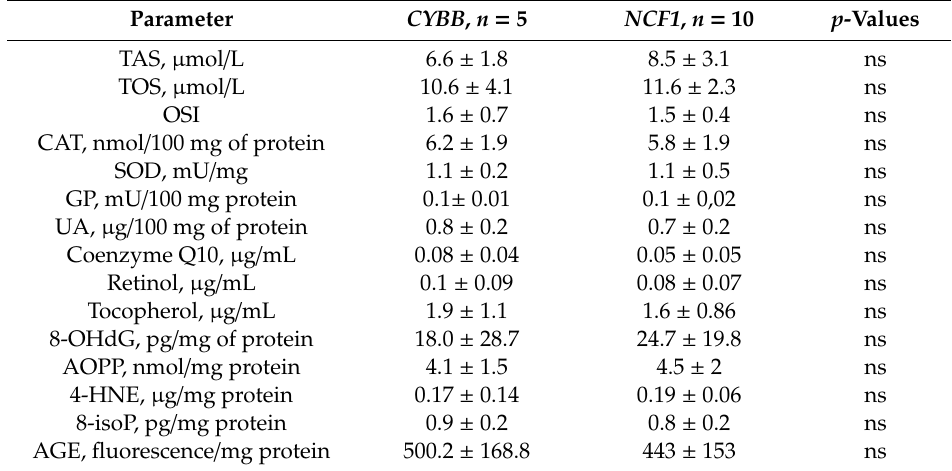
Table 3. Comparison of examined redox parameters in chronic granulomatous disease (CGD) patients with CYBB and NCF1 mutations.